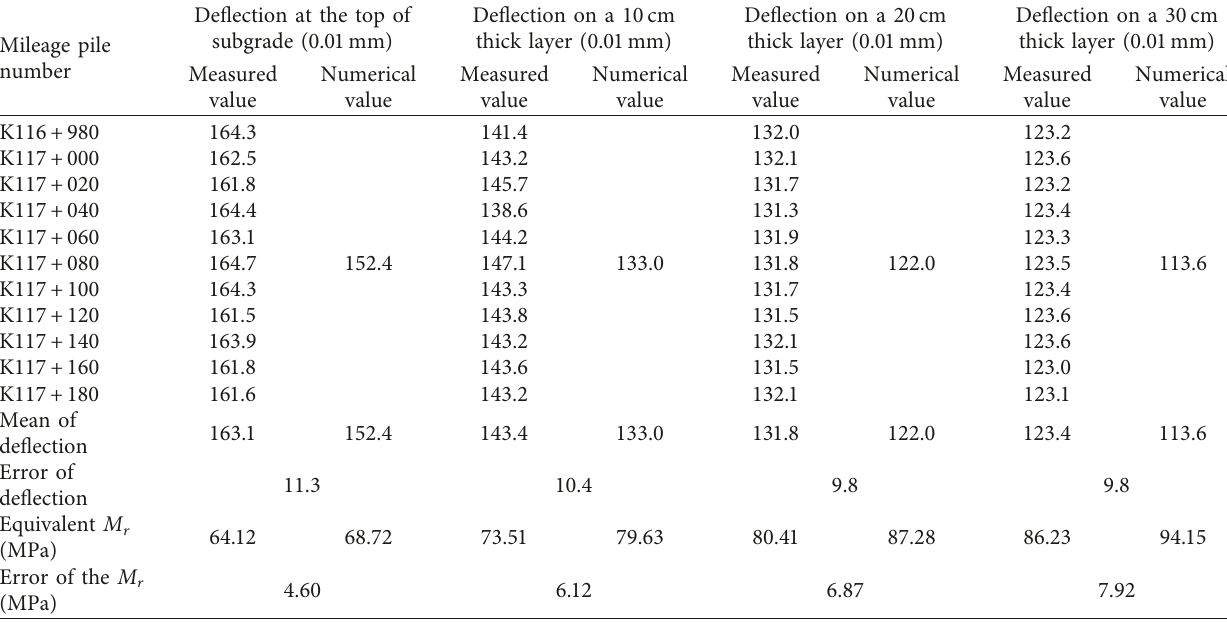
Table 2: Results of the numerical value and PFWD-measured value of deflection at the wheelmark belt. Mileage